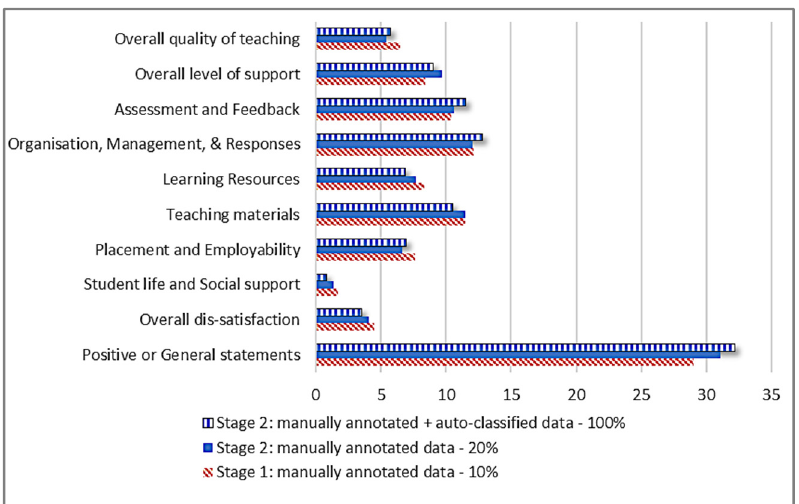
Figure 7. Relative frequency (%) of statements (manually annotated and auto-classified) per category using the annotation scheme developed.